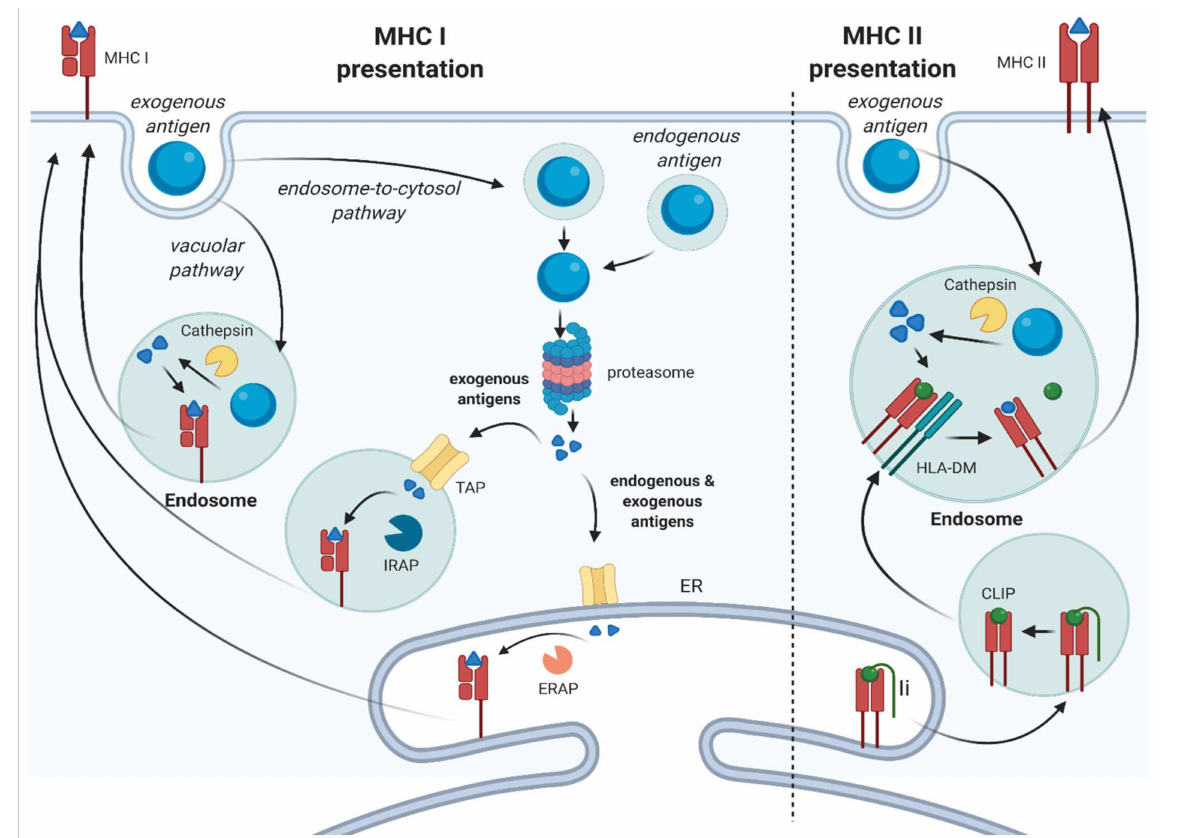
Figure 1. Exogenous antigen processing. MHC I presentation: in the endosome-to-cytosol pathway, exogenous soluble and particulate antigens are processed by the proteasome and enter either the ER or the endosome via TAP and are further processed by ERAP or IRAP, respectively. Endogenous antigens are also processed by the proteasome in the cytosol and enter the ER. Then, the antigens are loaded on the MHCI. In the vacuolar pathway, the antigen is processed by cathepsin S and is loaded onto the MHCI in an endosome. MHC II presentation: the antigen is processed by cathepsins in the endosome after internalization. The MHCII molecule is formed in the ER and Ii is cleaved in the endosome, which leaves CLIP in the binding pocket of MHCII. In the endosome, CLIP is removed by HLA-DM, so the antigen can bind. ER: endoplasmic reticulum; Ii: invariant chain; CLIP: